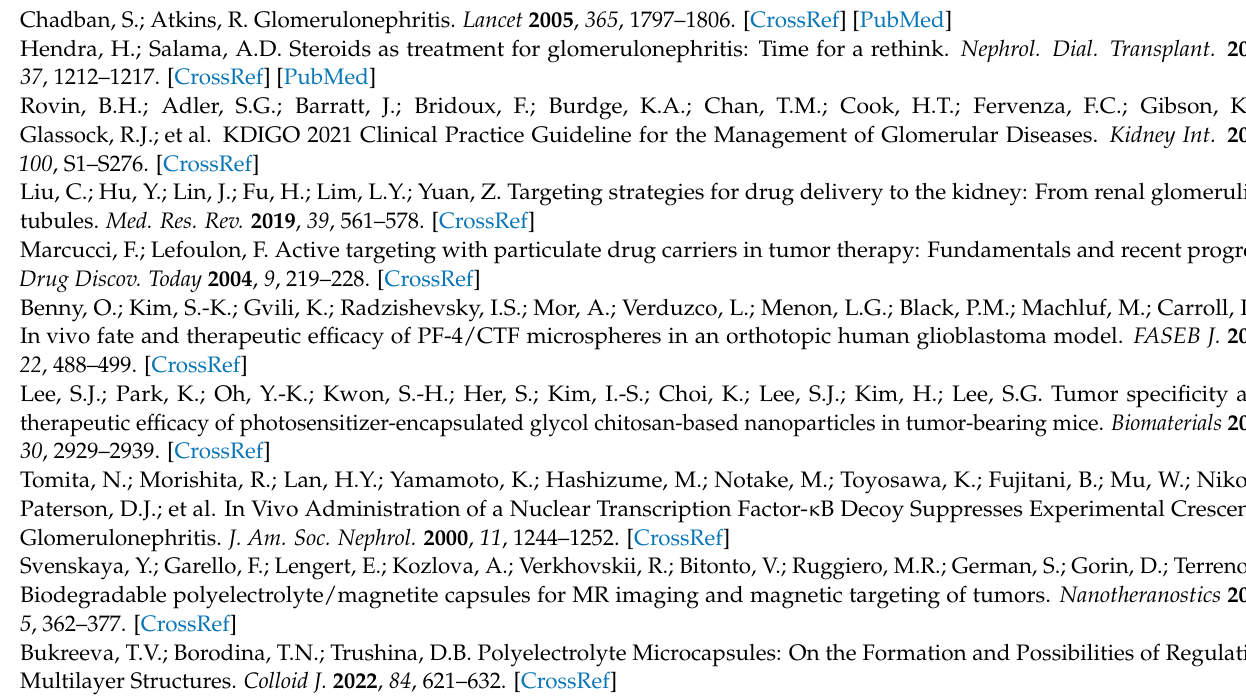
Figure A3. Acute inflammatory process in the renal tissue induced by injection of 20 µL of complete Freund’s adjuvant under the capsule of the left kidney (2.5 months after injection) ( A – D ): macrofocal leukocyte infiltrates as a response to the adjuvant action (1); epithelial dystrophy or tubular lumen occlusion (2); local accumulation of immune cells in the parenchyma (infiltrate) (3); vascular plethora (4); degeneration of glomerular capillaries, collapse of Bowman’s capsule (5); small foci of the renal parenchyma sclerosis (6); multicellularity and glomerular edema - a sign of inflammation, narrowing of the Bowman ’ s capsule lumen (7); renal tubules with signs of the epitheliumapical dystrophy (8). The thickness of the histological samples is 5 μm; dyes: hematoxylin and eosin. The scale bar is 200 µm.